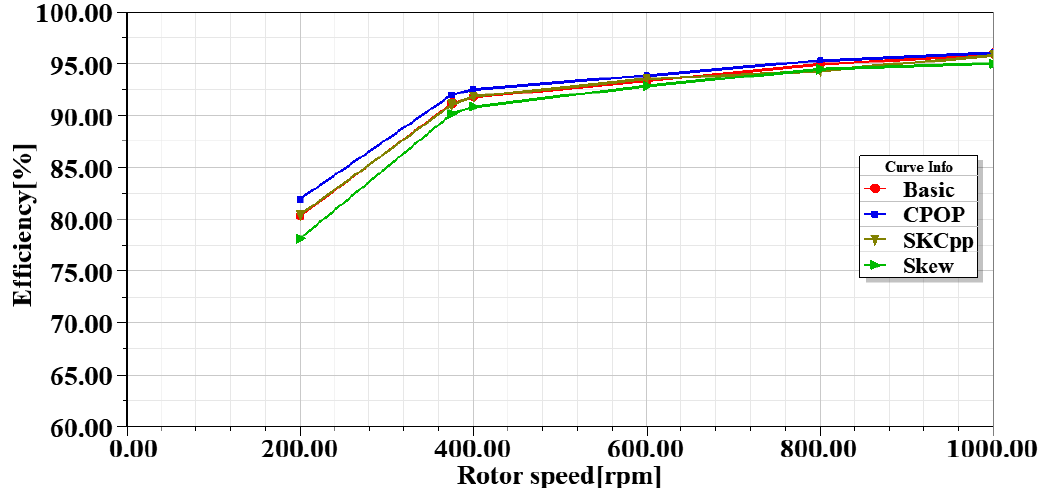
Figure 35. Efficiency against rotor mechanical speed (rpm) for each rotor design @ 375 r/min.